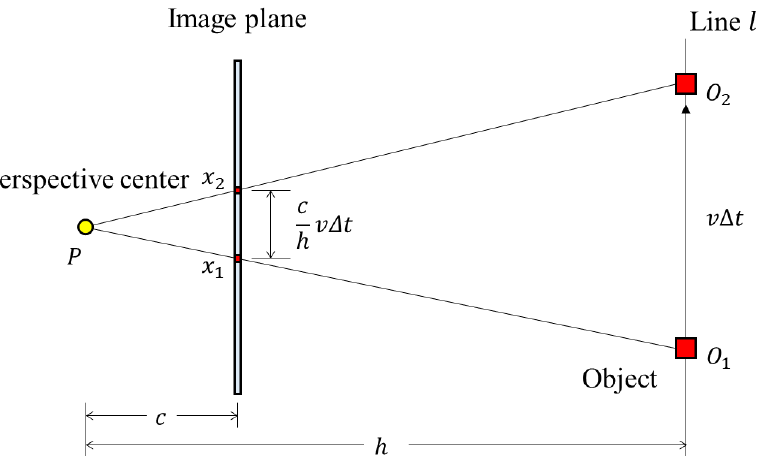
Figure 5. The RSE occurrence with the camera parameters and the moving scenario parameters (object moves sideways).